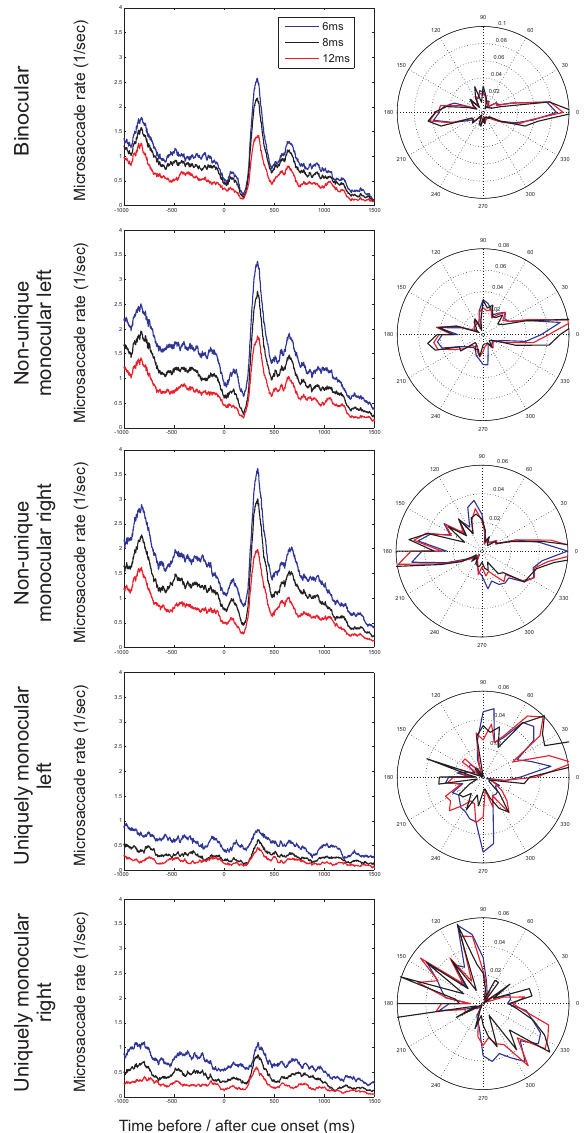
Figure 10 . Microsaccade rates as a function of time before and after cue onset (left) and microsaccade directions be- fore cue onset (right) for different minimum durations of mi- crosaccades (6ms, 8ms, and 12ms; presented results restricted to horizontal cue